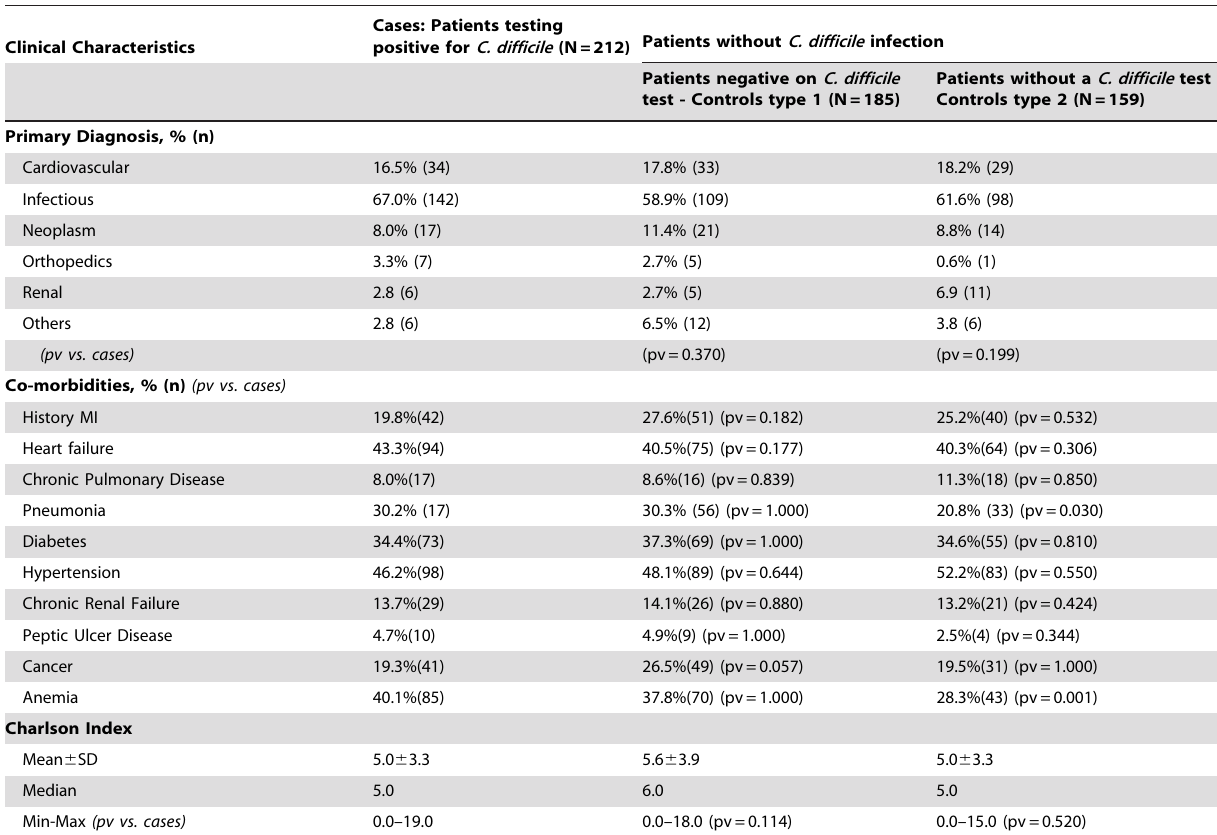
Table 3. Clinical Characteristics of the study population at admission, by study groups.